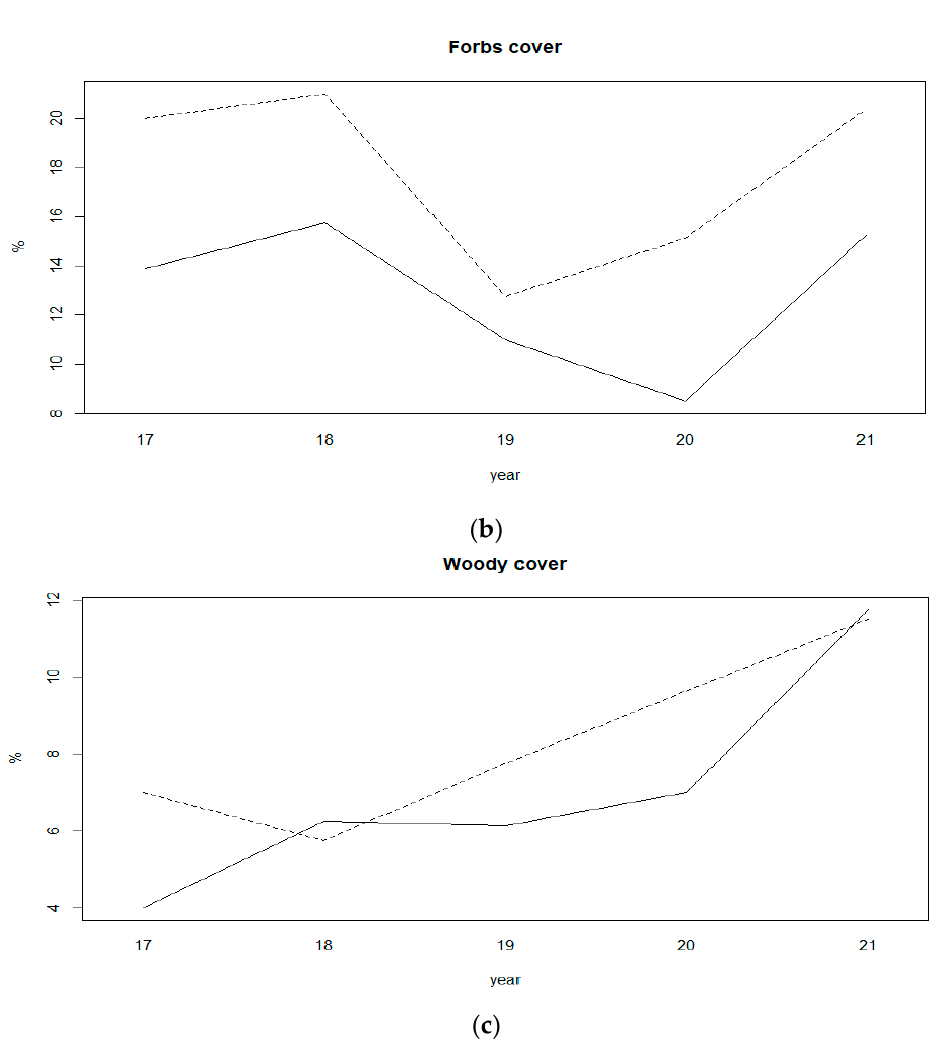
Figure 3. Average percentage variation of ( a ) grass cover, ( b ) forb cover, and ( c ) woody species cover along the five sampling years. Solid line for excluded plots vs. dotted line for control plots.